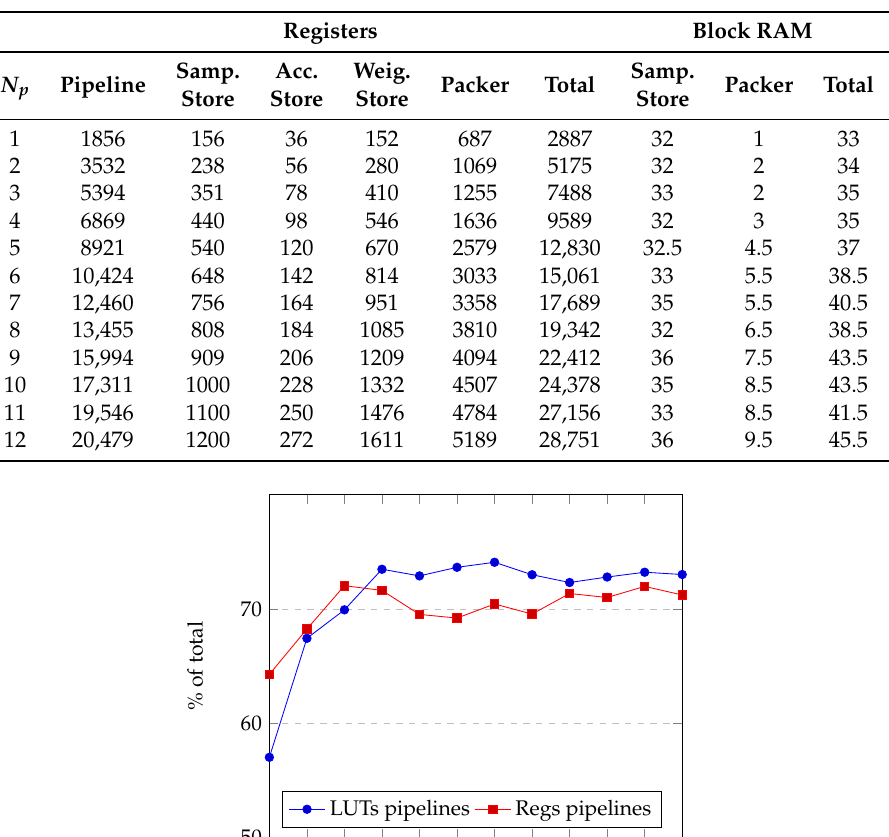
Table 3. Memory element use in various stages for different N p .